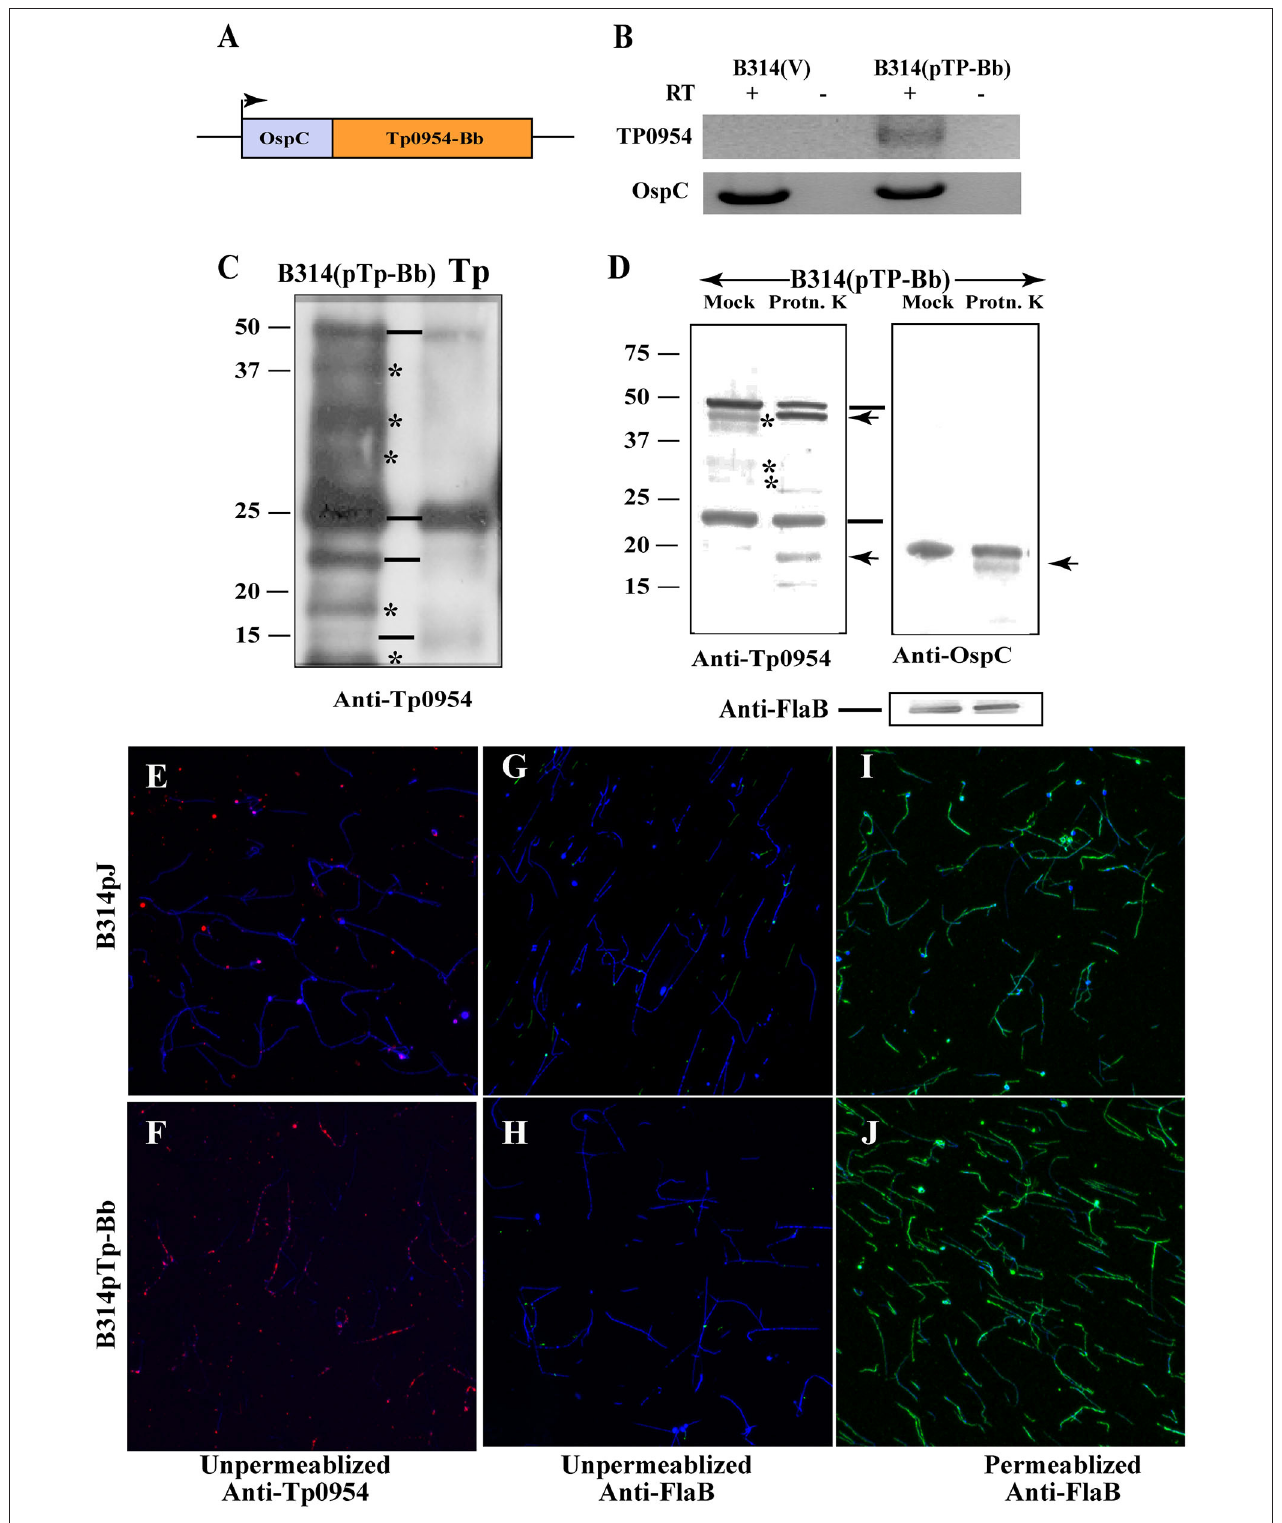
FIGURE 1 | Expression of Tp0954 in B. burgdorferi B314 strain and detection on the surface of transformed spirochetes. (A) Schematic of the construct expressing the Tp0954 coding region driven by the B. burgdorferi ospC promoter (pTp-Bb). (B) Tp0954 expression in B314(pTp-Bb) and not vector transformed B314(V)